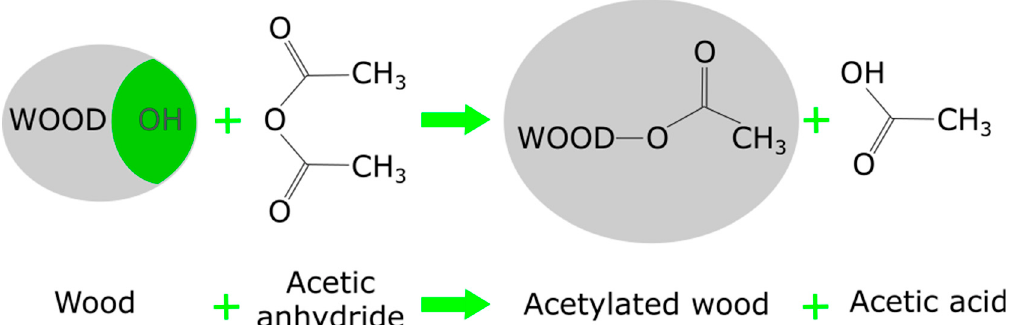
Figure 2. Schematic reaction of a wood hydroxyl group with acetic anhydride to produce acetylated wood and acetic acid as a by-product (own representation based on [44]).